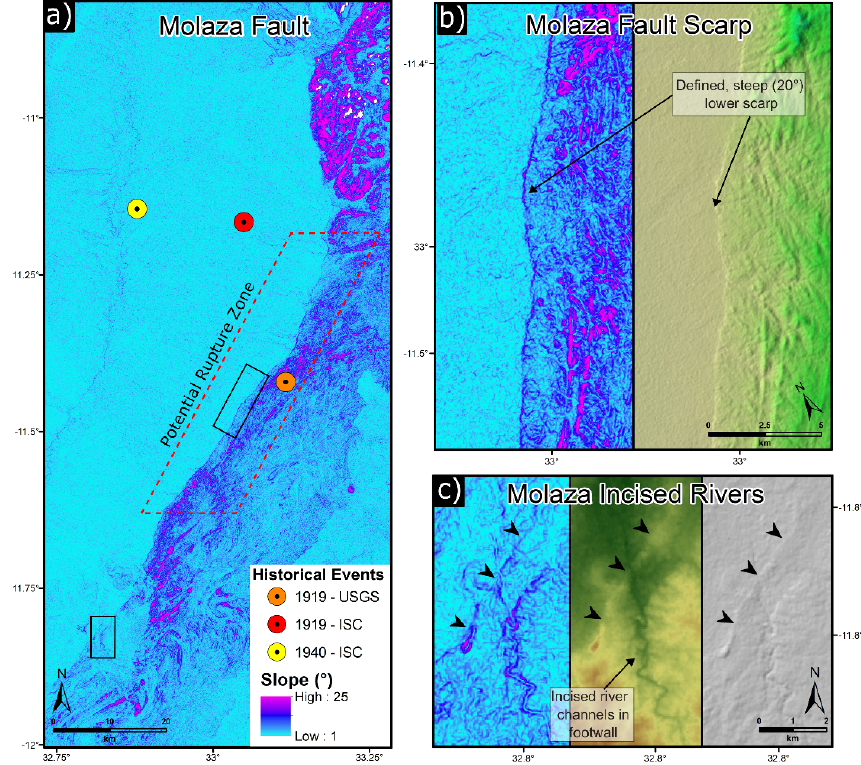
Figure 6. Evidence of Quaternary activity along the Molaza Fault. (a) Slope map of the Molaza Fault overlaid with different estimates of the epicentre of two major 20th century earthquakes that occurred within the rift on 1 May 1919 ( M 6.7) and 1940 ( M w 6.3). The source depth for both events is essentially unknown (quoted as 15km depth in both catalogues). Both epicentres coincide with a portion of the fault where the Quaternary scarp is consistently preserved ( b ). Further evidence of activity is provided by steeply incised rivers in the footwall of the fault ( c